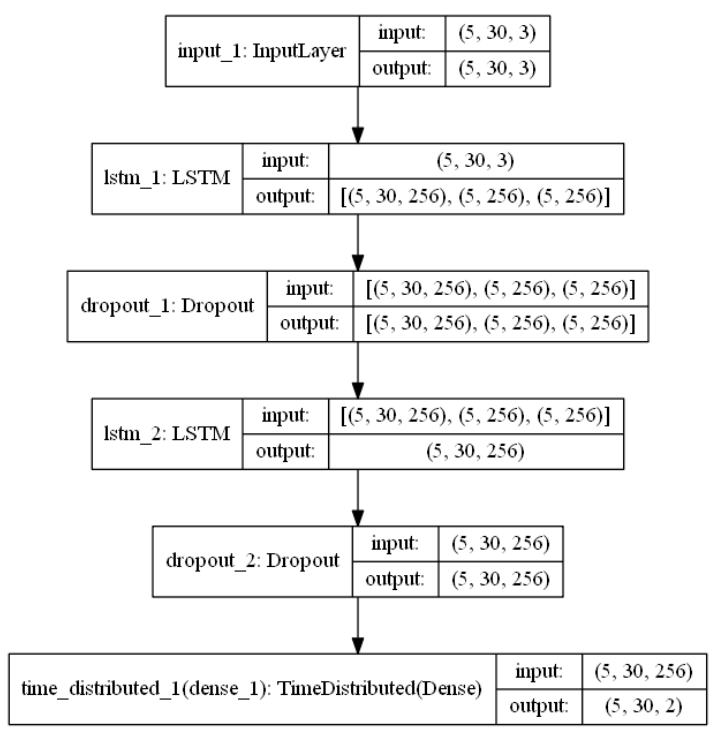
Figure 8. Model structure of proposed LSTM